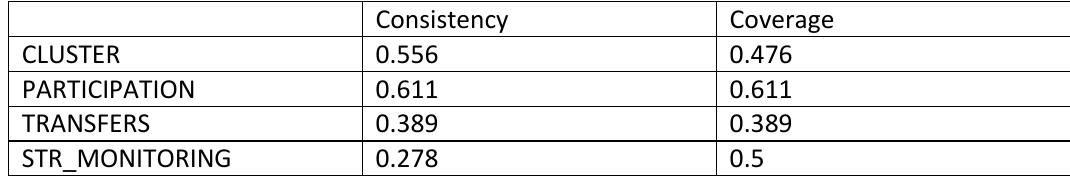
Table A2.6 Analysis of necessity for unsuccessful drought adaptation